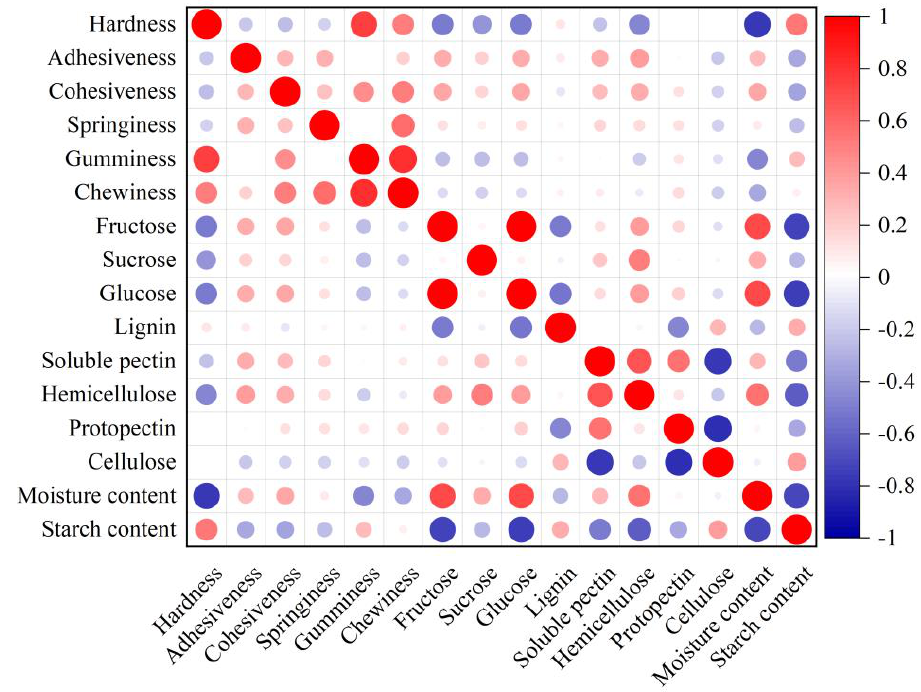
Figure 1. Correlation analysis of quality traits of sweet potato tuberous roots ( n = 81). Adhesiveness has a strong positive correlation with cohesiveness, springiness, and fructose, glucose, soluble pectin, and hemicellulose content (R = 0.286, R = 0.320, R = 0.328, R = 0.329, R = 0.326, and R = 0.387, respectively; p < 0.01) and a negative correlation with starch content (R = − 0.333; p < 0.01). This indicates that a high adhesiveness accompanies a high soluble content, especially regarding glucose and fructose content. Cohesiveness